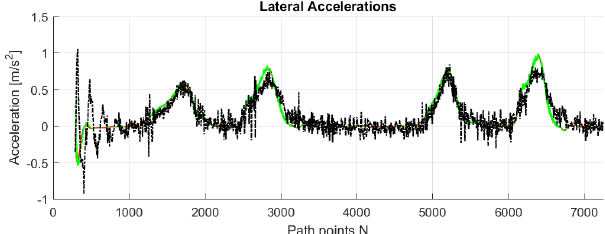
Figure 12. Lateral acceleration for simulations and test